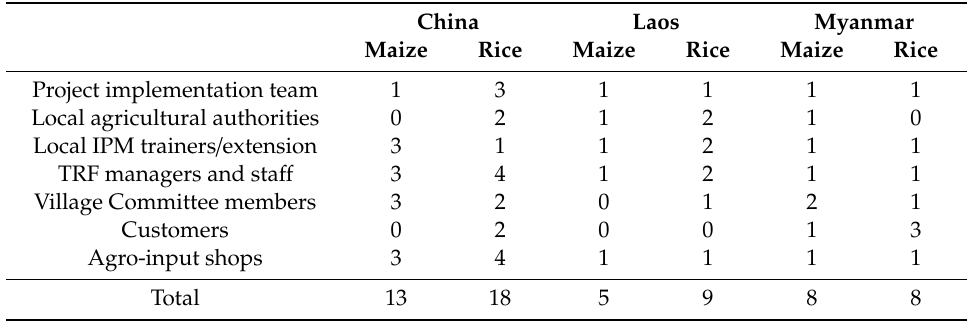
Table 2. Number of key informant interviews conducted in the three target countries for the maize and rice crop (total =